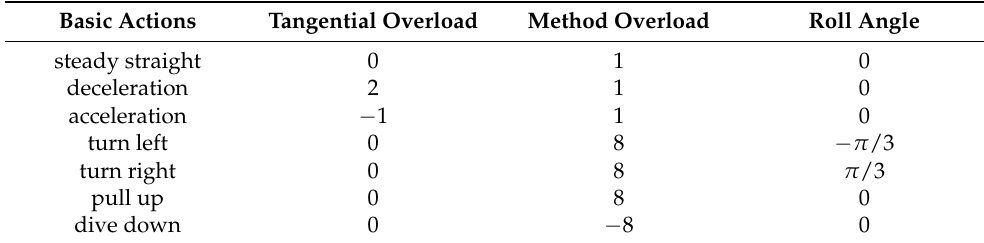
Table 1. The triplet code of seven basic